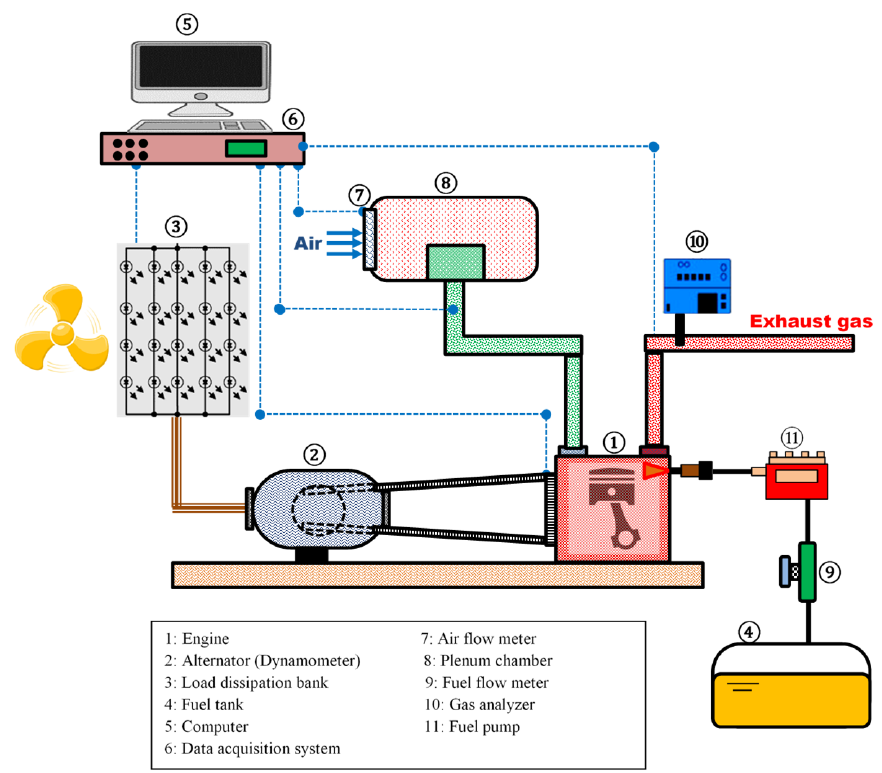
Figure 1. Experimental setup of the engine test rig. Table 3. Test engine specifications.